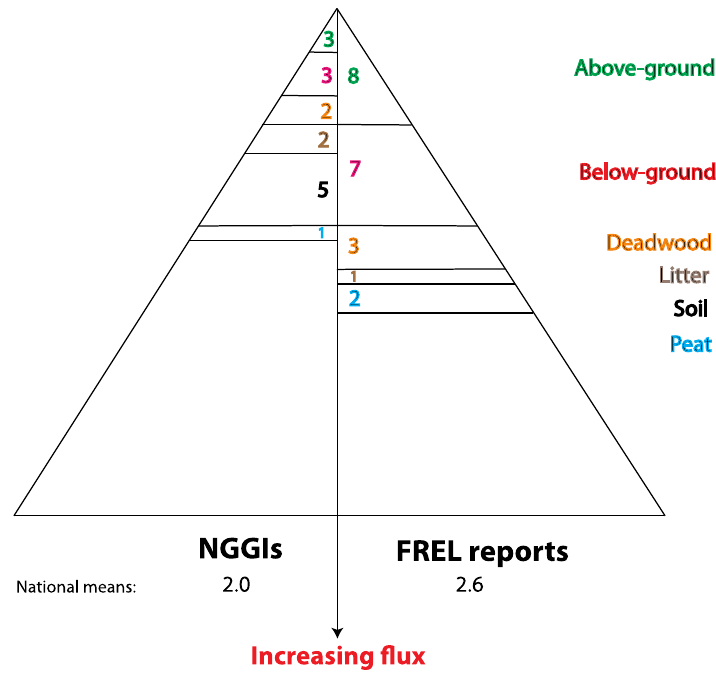
Figure 4. Understructuralization: the total numbers of carbon pools in estimates of forest carbon fluxes in the National Greenhouse Gas Inventories (NGGIs) and Forest Reference Emission Level (FREL) reports of eight tropical countries (see Table 5b) [55,59 – 65,67,71 – 77].